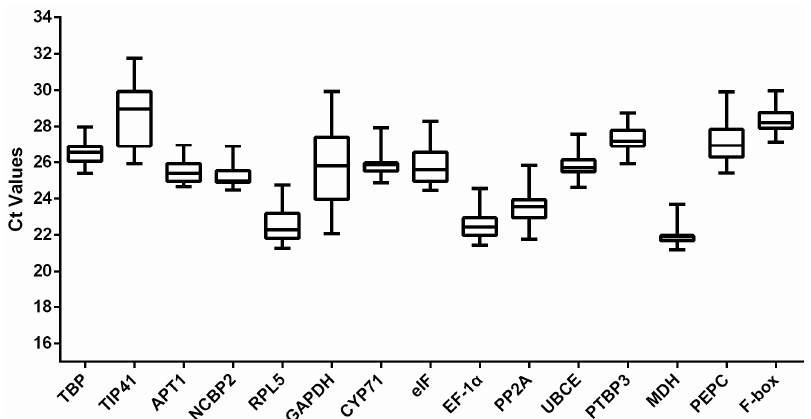
Figure 3. The comparison of raw cycle threshold (Ct) of the 15 candidate reference genes in different samples. The box graph indicates the 25th and 75th percentiles, with the lines in the center of the boxes indicate the medians. The whisker caps represent the maximum and minimum values, re- spectively.